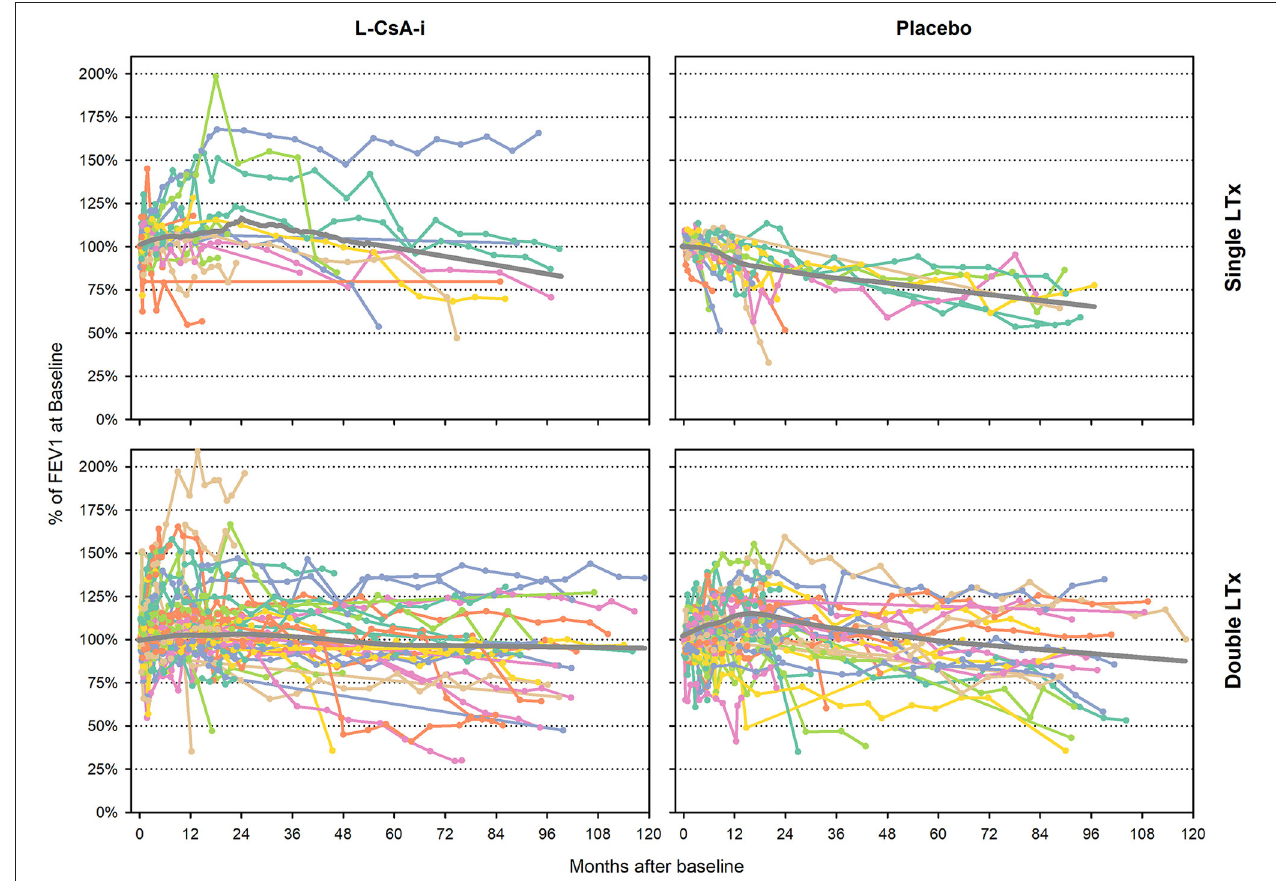
FIGURE 1 | Individual subject trajectories of FEV1 baseline % from baseline to end of follow-up. FEV1 baseline % of intraindividual baseline value—individual subject trajectories (Month 0 corresponds to the baseline assessment of study 12011.201). Gray lines represent LOWESS regression lines.